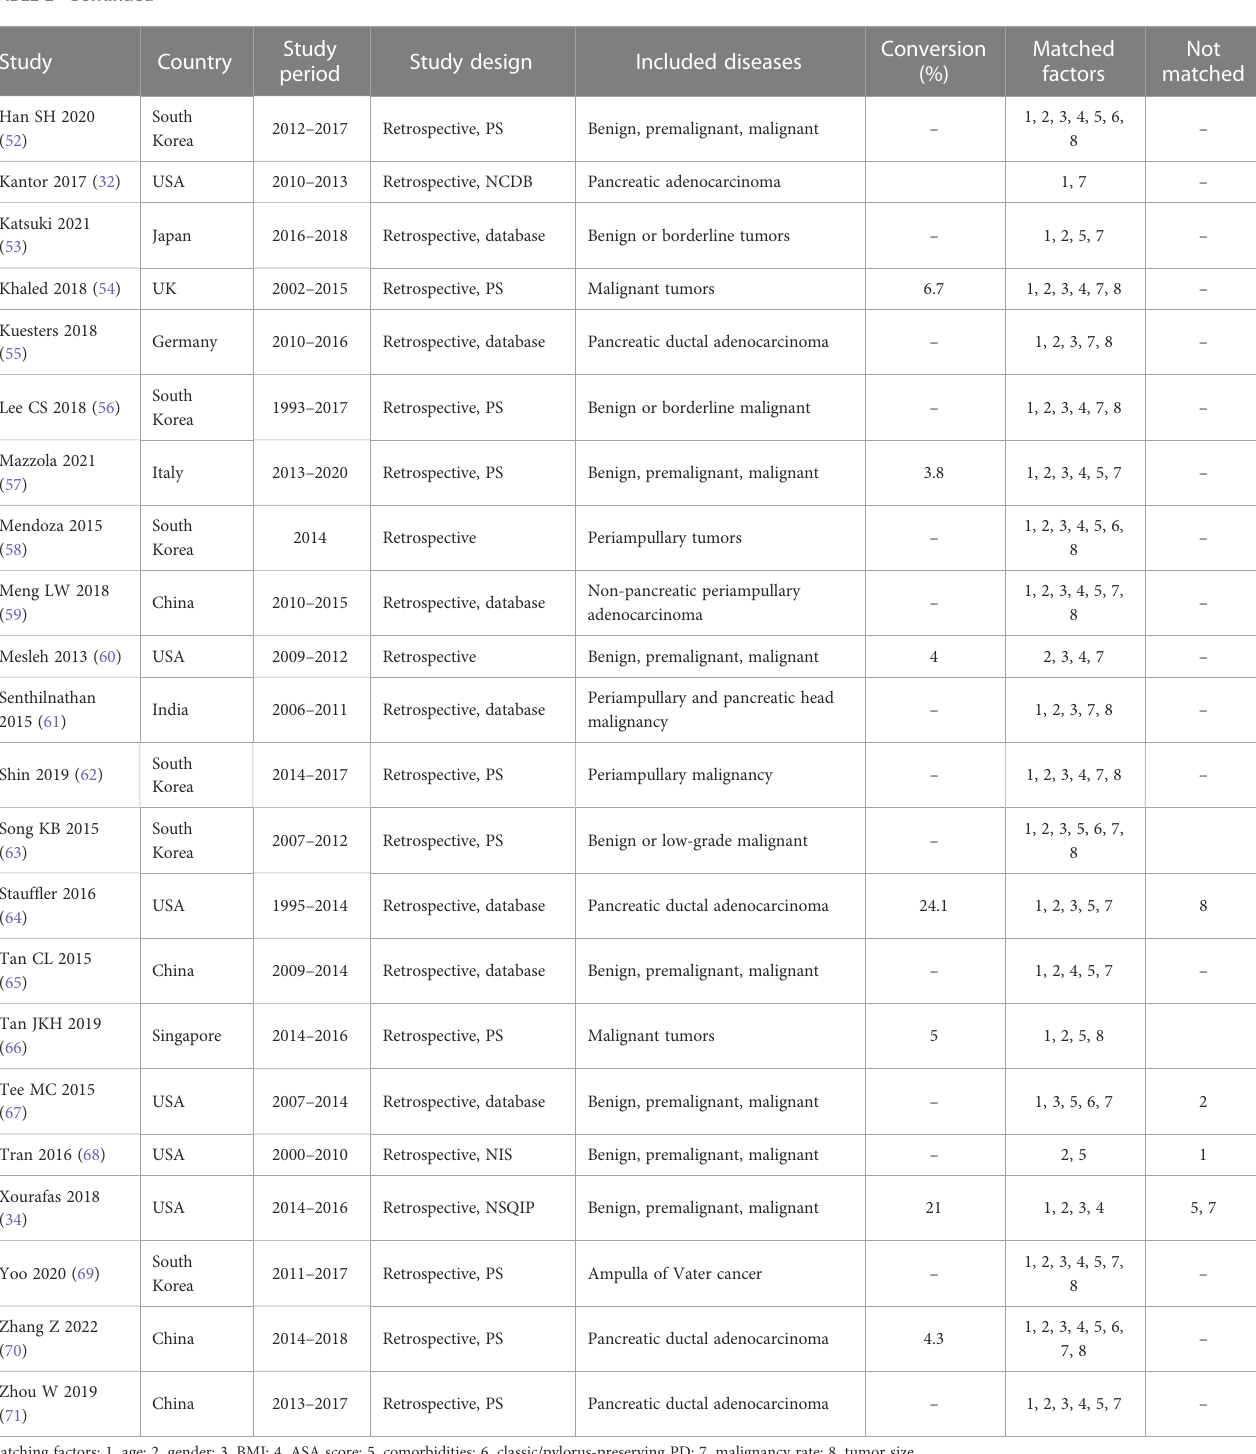
Among them, 818 (2.0%) cases were from the four included RCTs, 411 (9.6% of all LPD cases) of which were in the LPD group and 407 in the OPD group (1.1% of all OPD cases). However, in 17 studies, 14 NRCTs and 3 RCTs had LPD cases of no more than 50. The mean/ median age and body mass index (BMI) in each treatment group ranged from 49.6 to 76.5 years and 21.3 to 28.7 kg/m 2 , respectively.